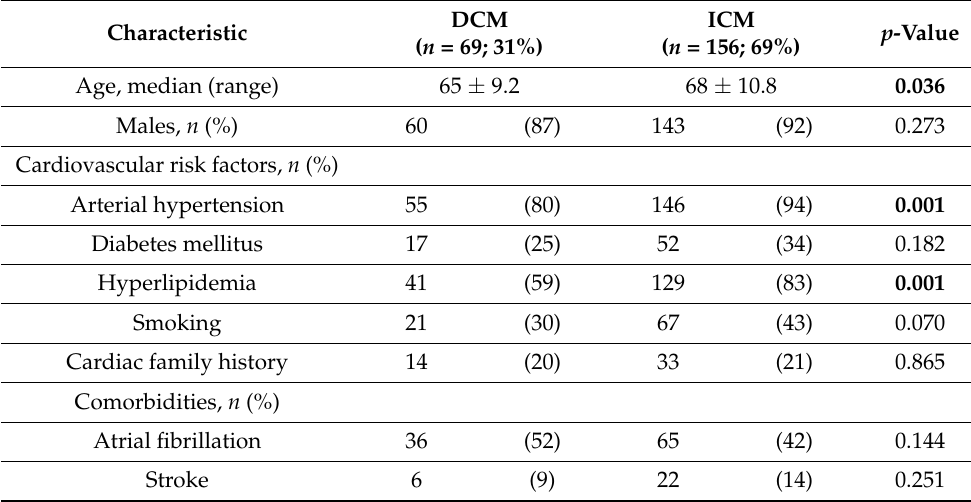
Table 1. Baseline